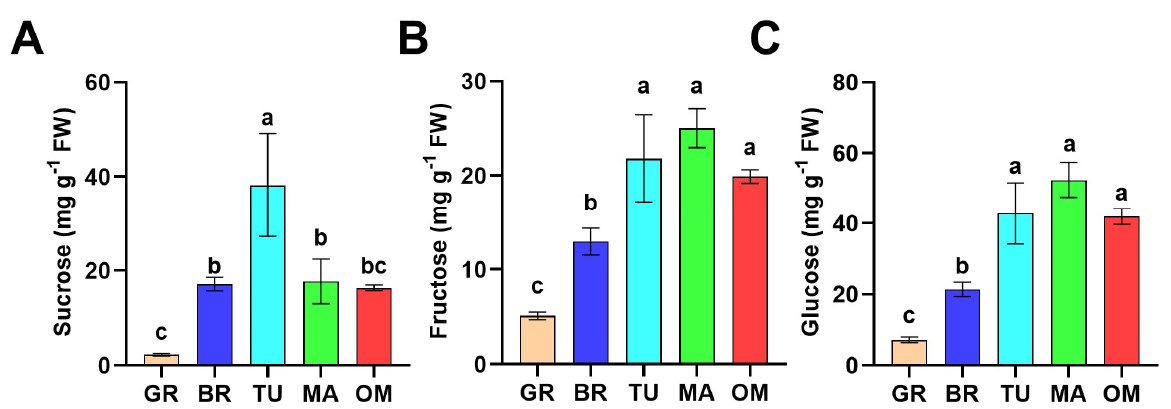
Figure 2. Changes of sugar accumulation during tamarillo fruit ripening. The contents of sucrose ( A ), fructose ( B ), and glucose ( C ) of fruits at different ripening stages. Data represent the mean ± SD ( n = 3). Means denoted by the different letters significantly differ at p < 0.05 according to Tukey’s test. GR, Green ripe; BR, Break; TU, Turning; MA, Mature; OM, Over-mature. FW: fresh weight.